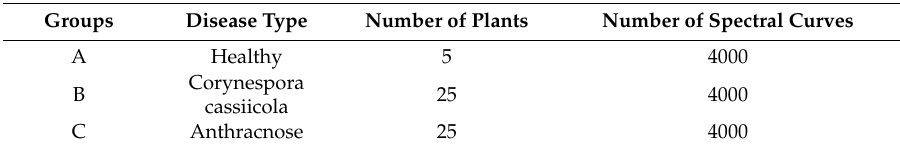
Table 1. A brief description of the groups.